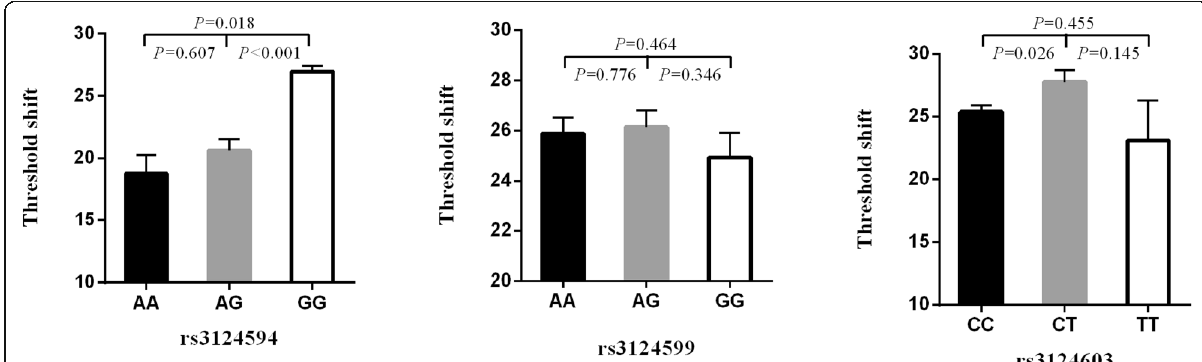
Fig. 1 Comparison of high-frequency hearing threshold shift of all subjects. Comparison of high-frequency hearing threshold shift of rs3124594, rs3124599 and rs3124603 genotypes in all subjects. Data are presented as mean ± SE and analyzed by